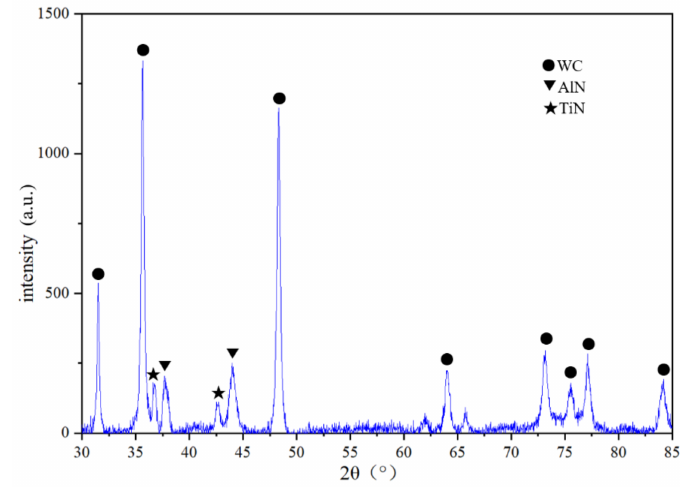
Figure 3. X-ray diffraction analysis of the composite coating.